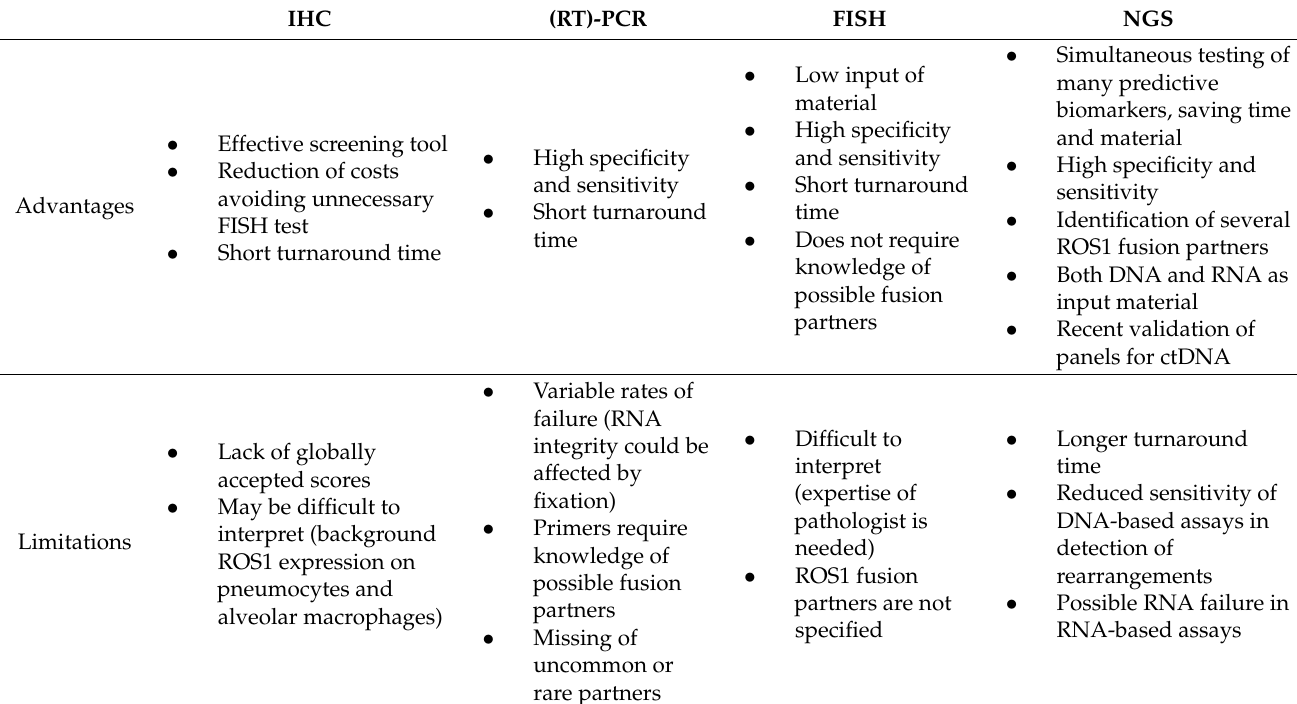
Table 1. Advantages and limitations of available diagnostic techniques for ROS1 rearrangement detection. IHC (RT)-PCR FISH